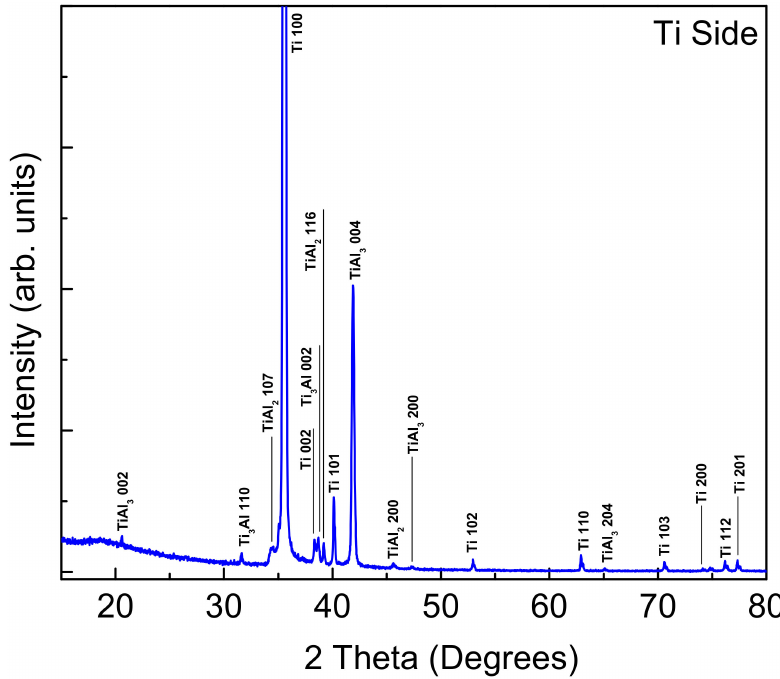
Figure 4. XRD pattern of the fractured surface (Al7075 side) for the sample bonded at 520 ◦ C, holding pressure of 10 MPa, and holding time of 10 min.